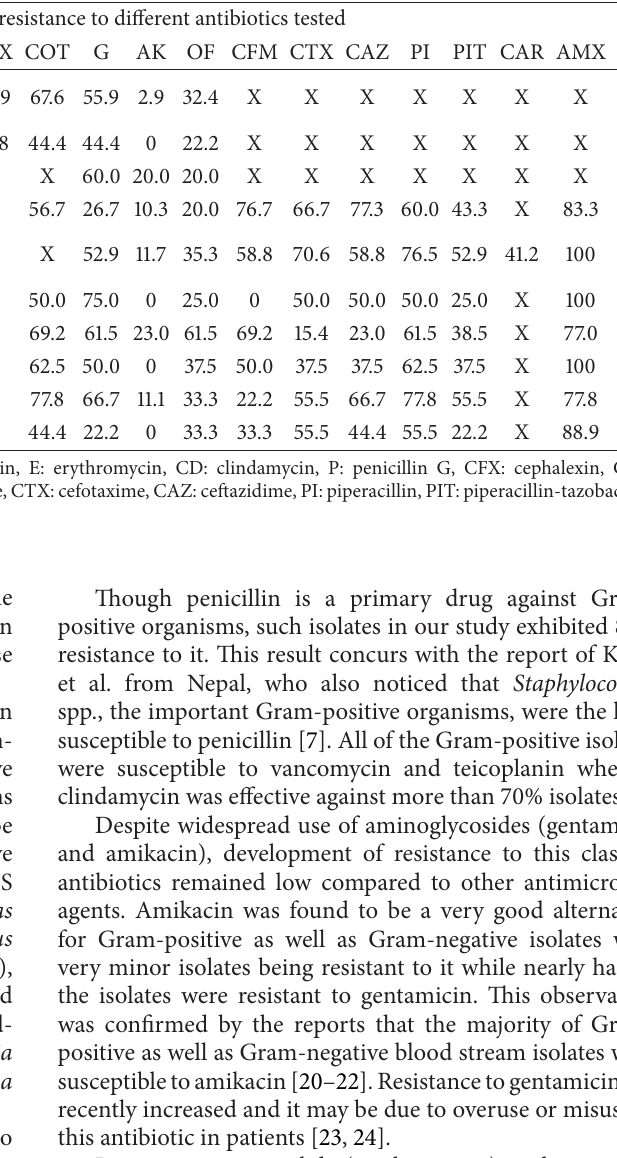
Table 3: Antibiotic resistance profile of